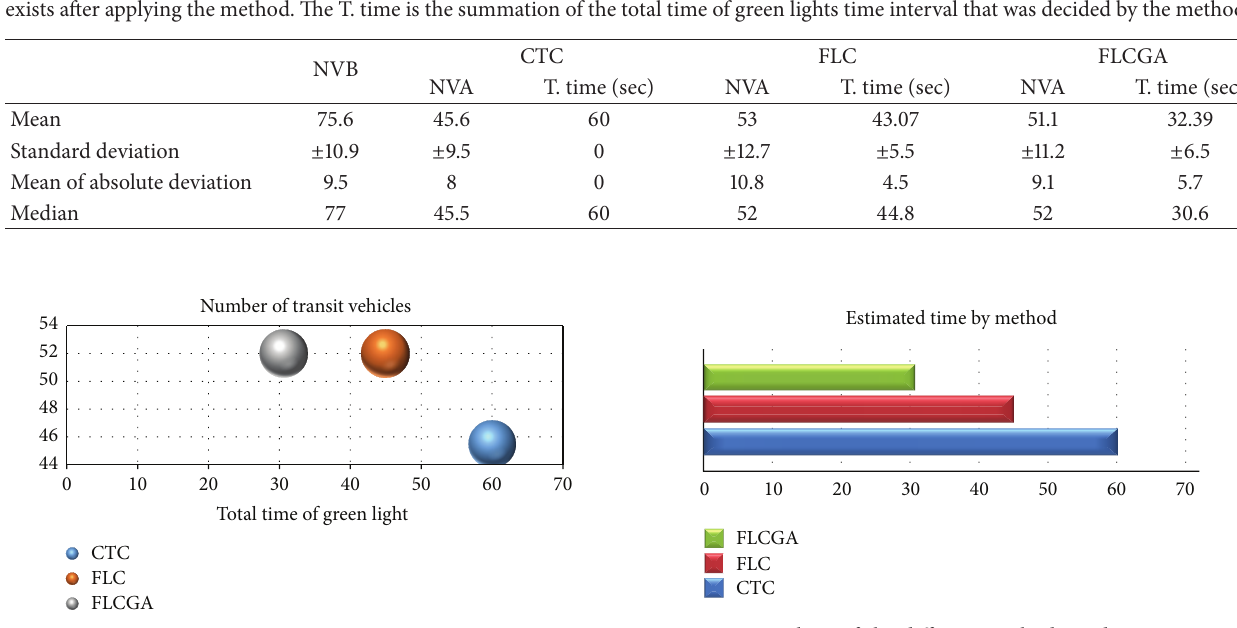
Figure 8: Estimation of green light time interval for the intersection in three methods: CTC, FLC, and FLCGA.